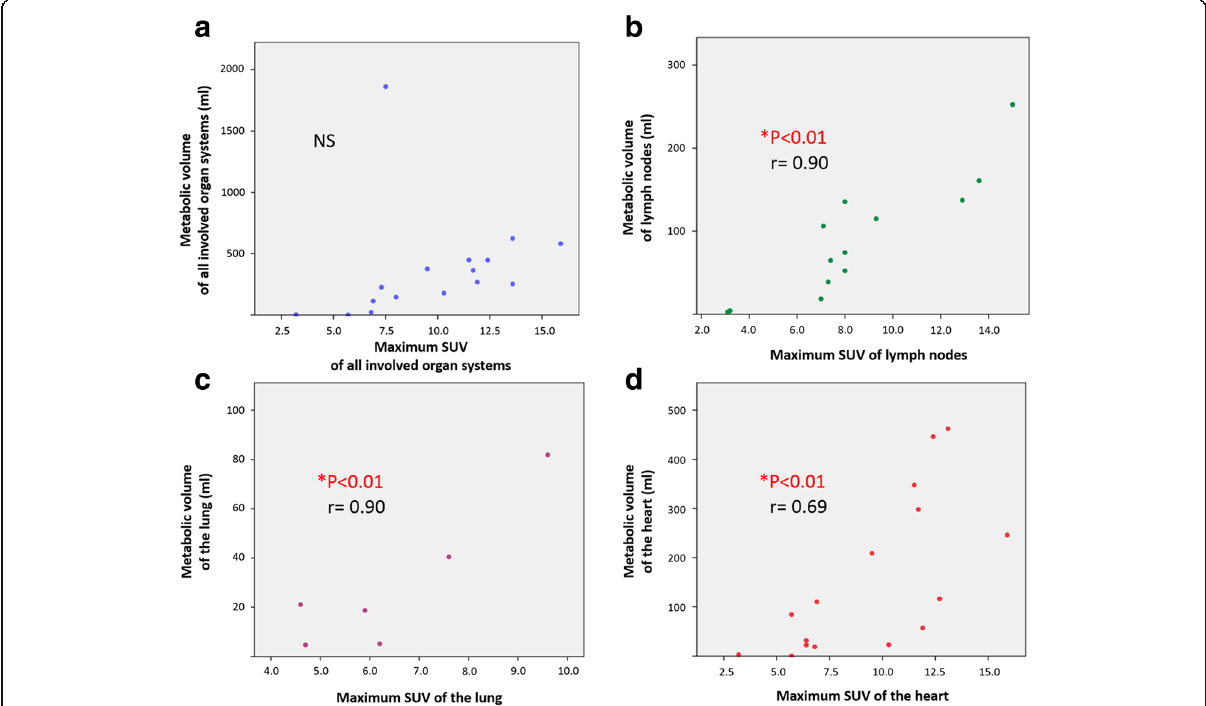
Fig. 5 Relationship between the max SUV and metabolic volume of all involved organ systems including the heart ( a ), lymph nodes ( b ), lung ( c ), and heart ( d ). * represents statistically significant